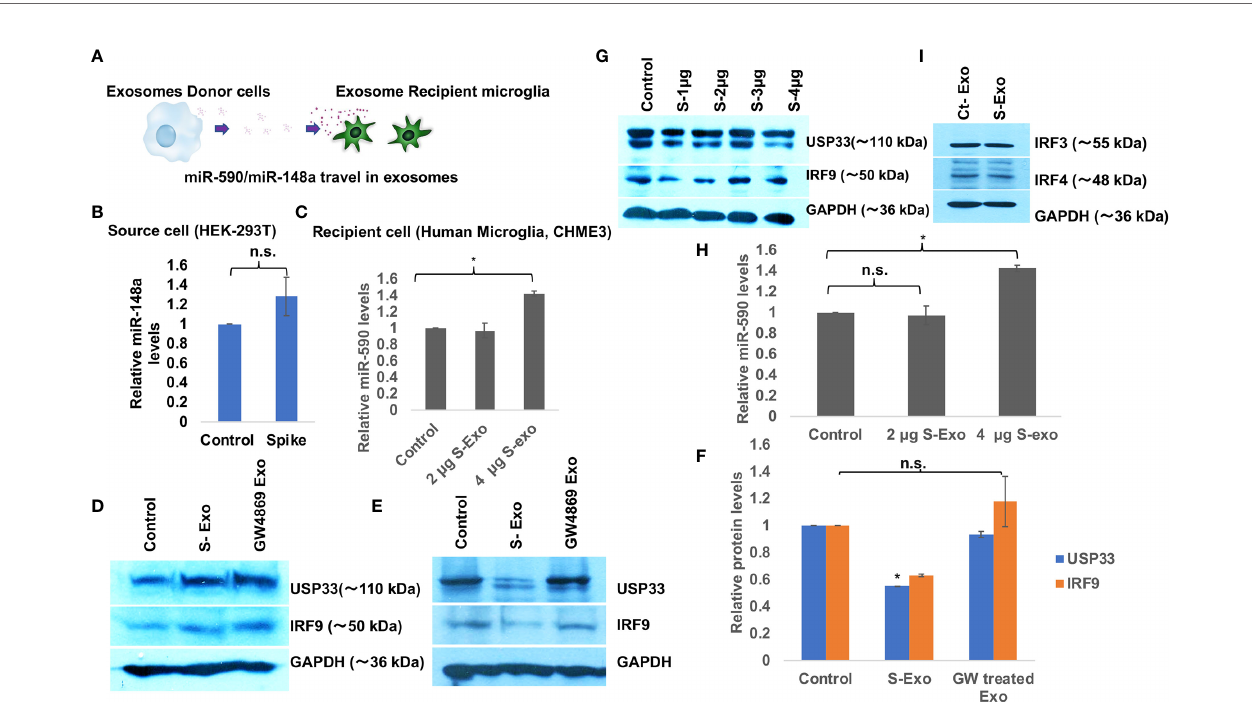
FIGURE 2 | Spike transfected cells release exosomes to suppress USP33 and IRF9 in human microglia (A) Schematic to demonstrate the Spike transfected HEK- 293T cells as exosome donor cells and human microglia CHME3 are recipient cells for those released exosomes. These exosomes carry miR-148a and miR-590 as their cargo. (B) Graph bars showing levels of miR-148a in source cell i.e. HEK-293T cells after Spike transfection. (C) Graph bars indicating the increase in miR-148a levels in a dose dependent fashion in recipient human microglia. (D) Immunoblot images showing the cellular levels of USP33 and IRF9 in exosome source cells (spike transfected HEK-293T cell). (E) Immunoblot images showing decrease in USP33 and IRF9 expression levels in human microglia after receiving S-exosomes and GW-4869 treated exosomes from Spike transfected HEK-293T cells. (F) Graph bars showing average change in USP33/IRF9 levels after S-exo and GW-4869 treated exosomes. Densitometry analysis of western blot images were done on ImageJ 1.52q version software. GAPDH lane density have been used as normalizer for all image densitometry analysis. (G) Western blot image showing changes in USP33 and IRF9 levels after direct transfection of spike gene plasmids at different doses in microglia cell. (H) Graph bars showing relative miR-590 levels in recipient microglia cells after treatment with two doses of exosomes. (I) Western blot image showing almost no change in IRF3 and IRF4 gene expression levels upon S-exo treatment on human microglial cells. All the experiments have been biologically repeated at least three times to get the average change in expression levels. All graph bars are showing mean and mean ± S.E.M. student ’ s t-test have been done to get the statistical signi fi cance indicated as single * for p values